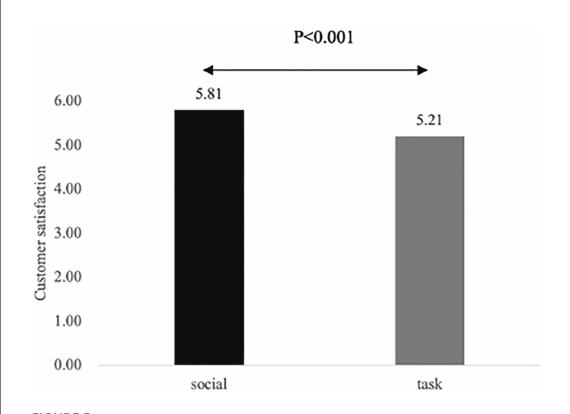
FIGURE 5 Mean values for customer satisfaction for Study